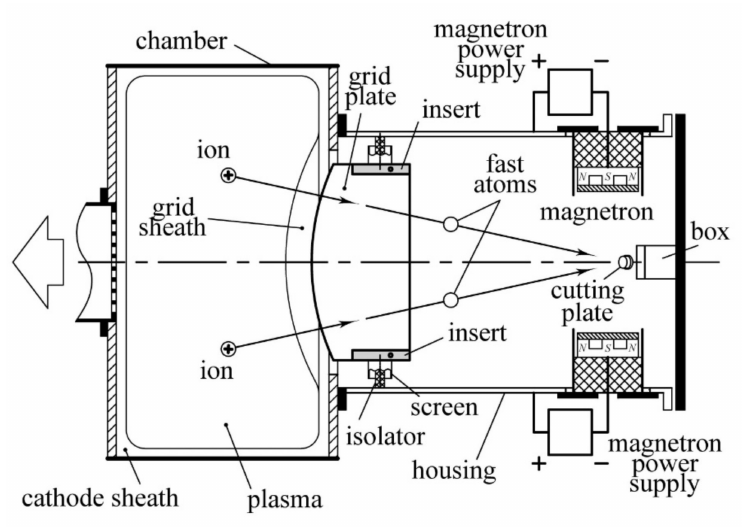
Figure 5. Experimental system for processing of dielectric cutting plates (view from